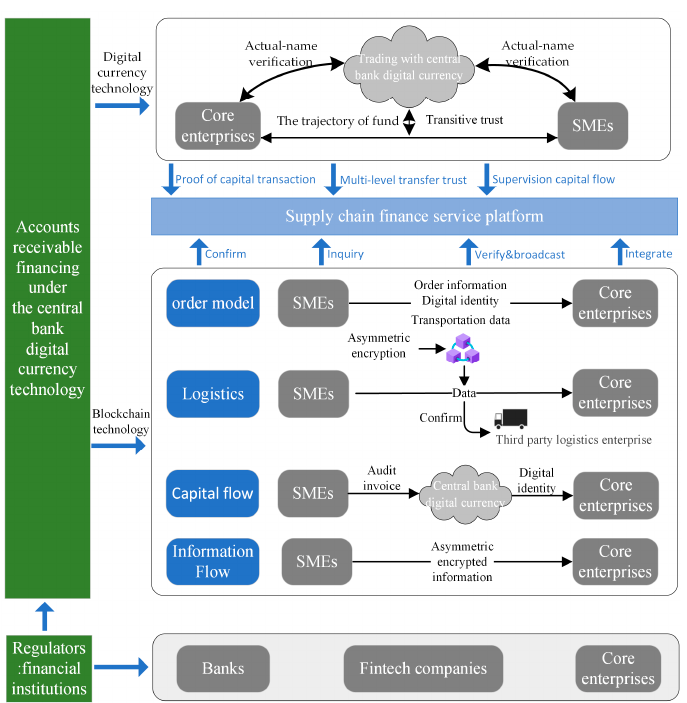
J. Theor. Appl. Electron. Commer. Res. 2023 , 18 , FOR PEER REVIEW Figure 3. Accounts receivable financing using central bank digital currency technology. Figure 3. Accounts receivable financing using central bank digital currency technology. Figure 3. Accounts receivable financing using central bank digital currency technology.